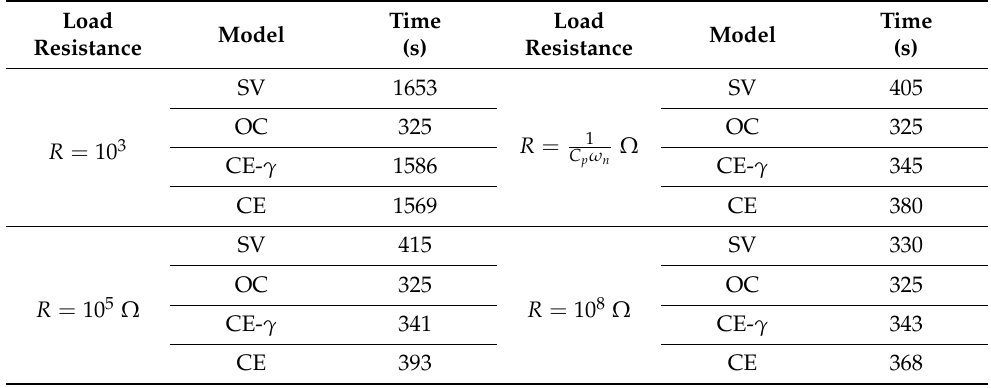
Table 4. Time variations between